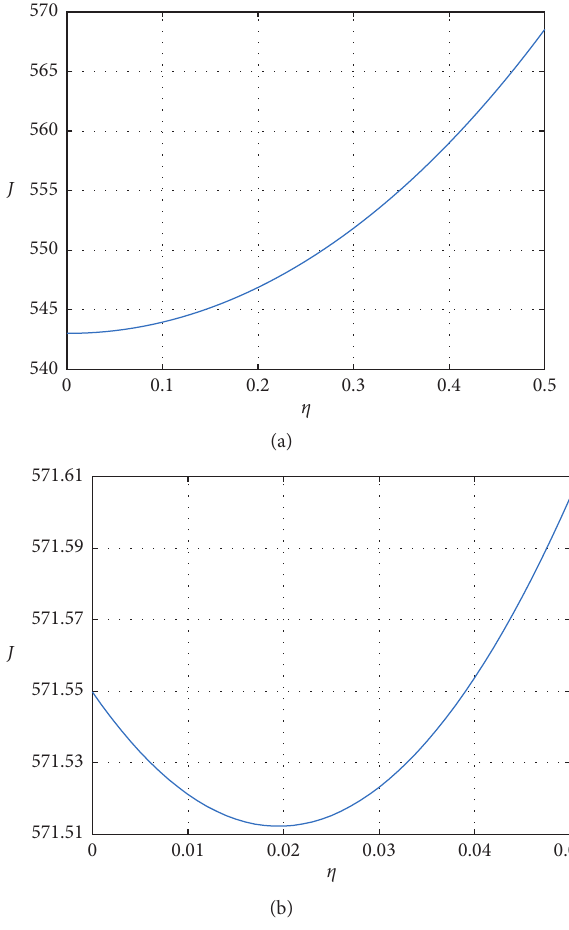
Figure 6: The total profit with respect to η under different initial � 15. (b) G � goodwill G . (a) G 0 0 0